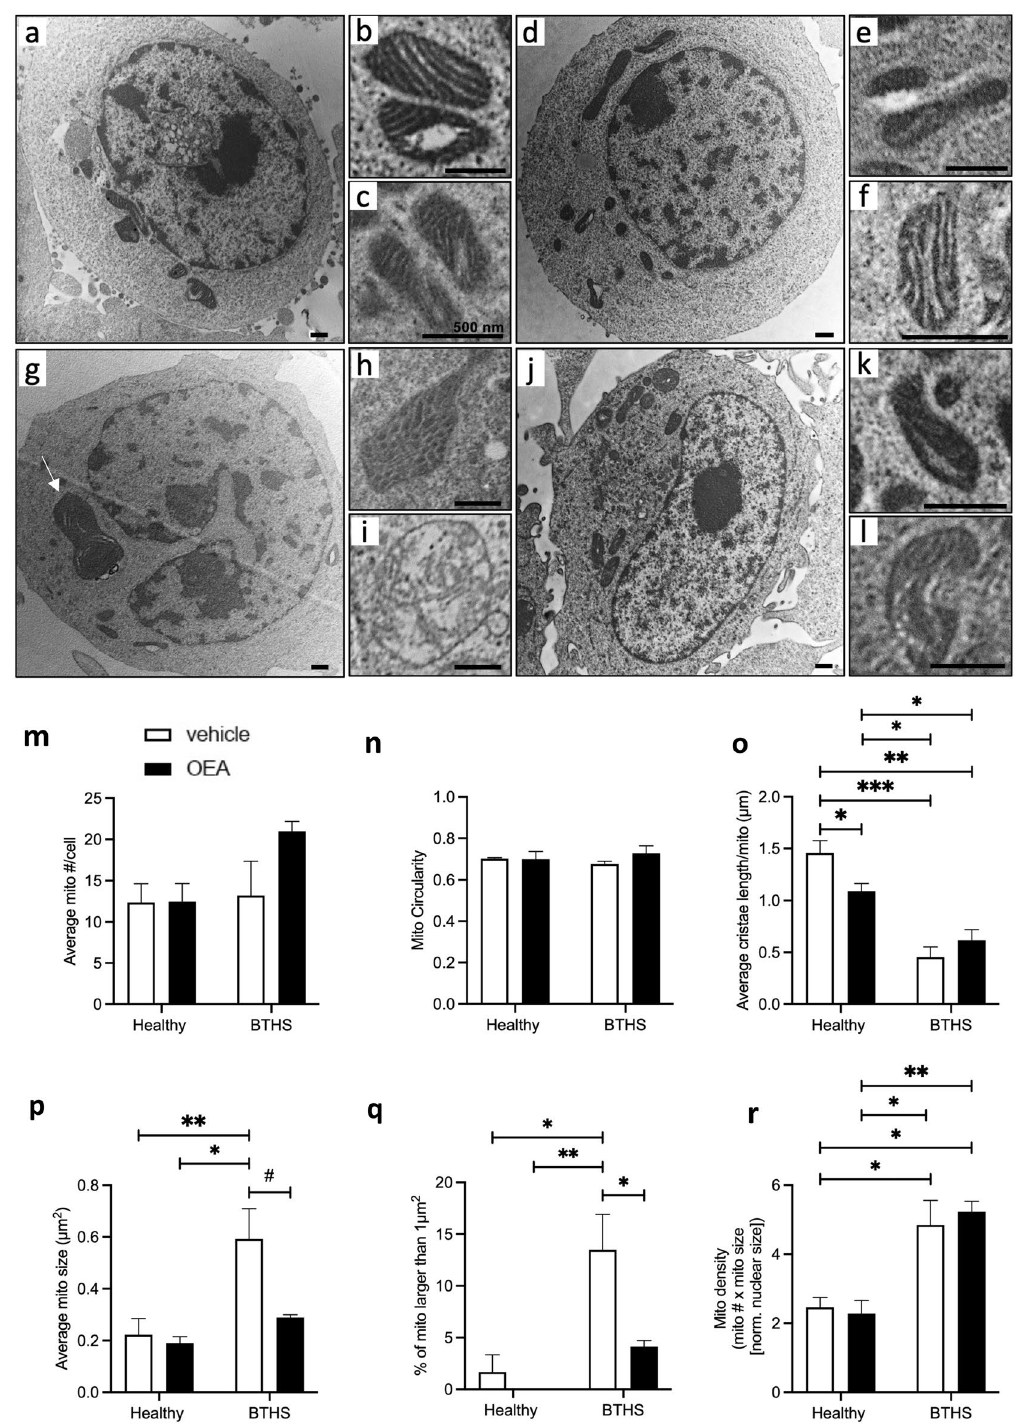
Figure 4. BTHS lymphoblasts have larger mitochondria that are reduced in size to healthy lymphoblast levels by OEA treatment . Representative whole cell and subcellular mitochondrial images are shown for vehicle-treated healthy lymphoblasts ( a–c ), 1 µM OEA-treated healthy lymphoblasts ( d–f ), vehicle-treated BTHS lymphoblasts ( g–i ), and 1 µM OEA-treated BTHS lymphoblasts ( j–l ). The white arrow in ( g ) shows a characteristic, atypically enlarged mitochondrion from a BTHS lymphoblast, while the image in ( h ) shows a mitochondrion with a ‘bubbly’ appearance, and the image in ( i ) shows a mitochondrion with an ‘onion-like’ appearance. Quantitative measures were derived from images produced from three of the BTHS and healthy lymphoblast lines after either vehicle treatment or treatment with 1 µM OEA for 4 days. The average number of mitochondria per cell (normalized to nuclear area to account for differences in cross-sectional area) is shown ( m ). Measures of mitochondrial morphology, including mitochondrial circularity ( n ), average total parallel cristae length per mitochondrion ( o ), average mitochondrial size ( p ), and the prevalence of atypically large mitochondria ( q ) are also reported. Scale bars = 500 nm. Data are means ± S.E.M; n = 3. # P = 0.06, *P < 0.05, **P < 0.01, ***P <